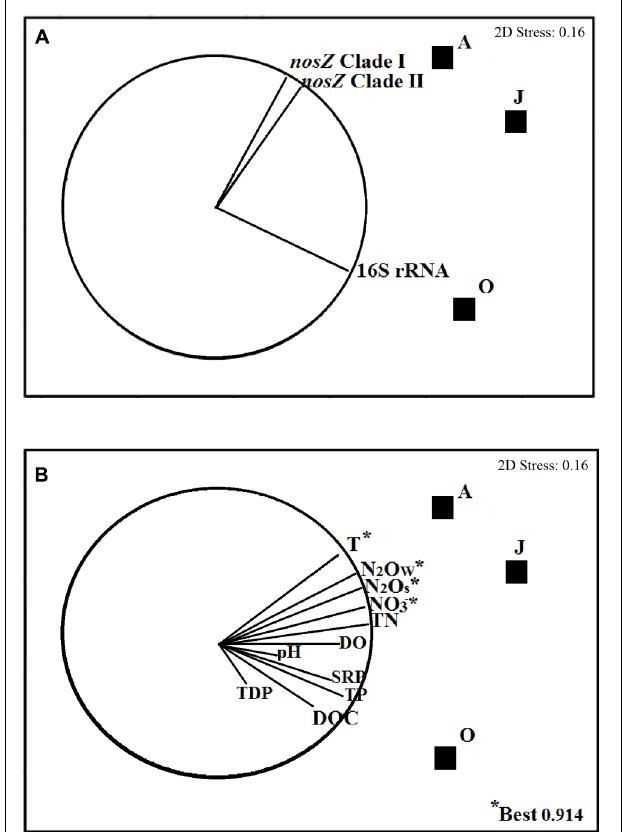
FIGURE 3 | Non-parametric multidimensional scaling (NMDS) plots illustrating ordinations of sediments samples from La Caldera lake (Sierra Nevada, Spain) over the ice-free season based on the abundance of copies of bacterial 16S rRNA and nosZ genes. Vectors in plots illustrate the direction and strength of the relationships between biotic (A) and abiotic variables (B) . Sampling months are represented by squares (June; August; October). The variables which best explained the distributions of the biological data according to BIO-ENV analysis are marked with an asterisk ( ∗ ). T, temperature; N 2 O W , production of N 2 O by water columns; N 2 O S , production of N 2 O by sediments; NO − 3 , nitrate content; TN, total nitrogen; DO, dissolved oxygen; SRP, reactive soluble phosphorus; TP, total phosphorus; DOC, dissolved organic carbon; TDP, total dissolve phosphorus. The N 2 O values used in plots are those obtained in samples that were incubated without